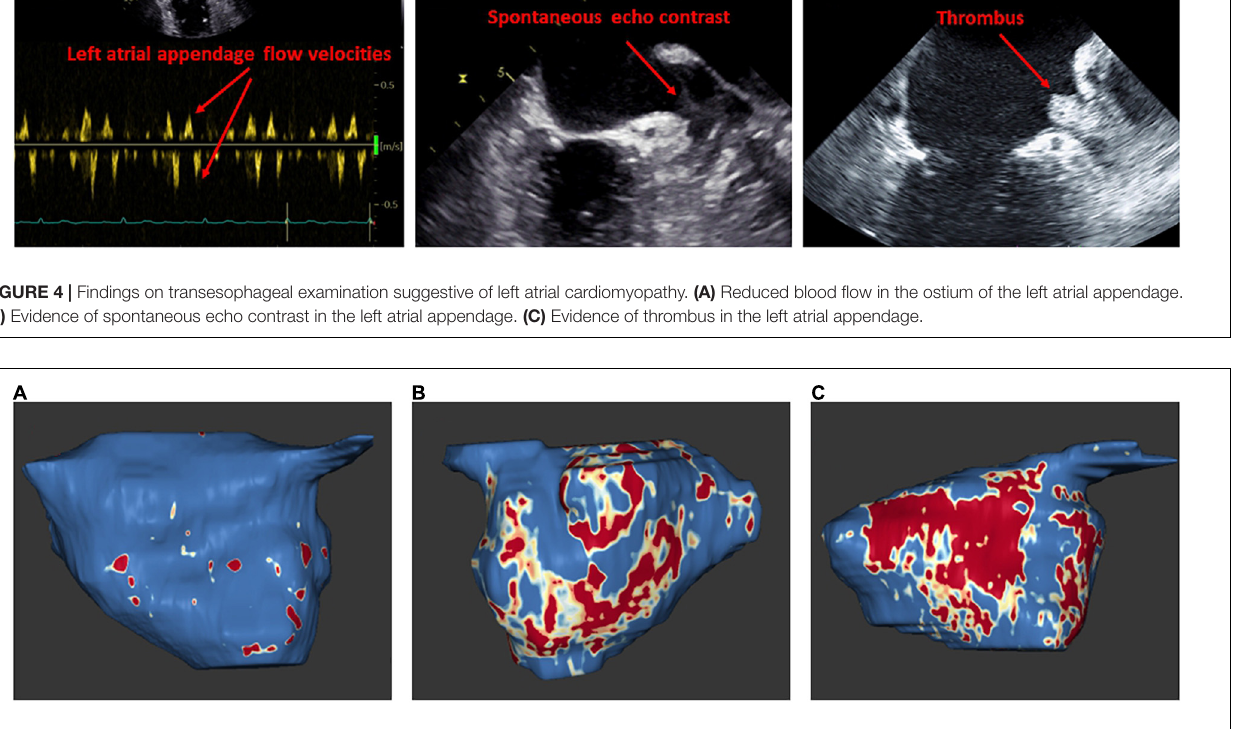
FIGURE 5 | Examples of MRI examinations of the left atrium: left atrial tissue fibrosis based on 3D delayed enhancement magnetic resonance imaging scans. Normal left atrial wall is displayed in blue, fibrotic changes are in red and white. Amounts of fibrosis as a percentage of the total left atrial wall volume. (A) Utah stage 1 (1%). (B) Utah stage 3 (27%). (C) Utah stage 4 (36%). With the friendly support of Dr. Misagh Piran (Herz- und Diabeteszentrum Nordrhein-Westfalen, Ruhr-Universität Bochum) .